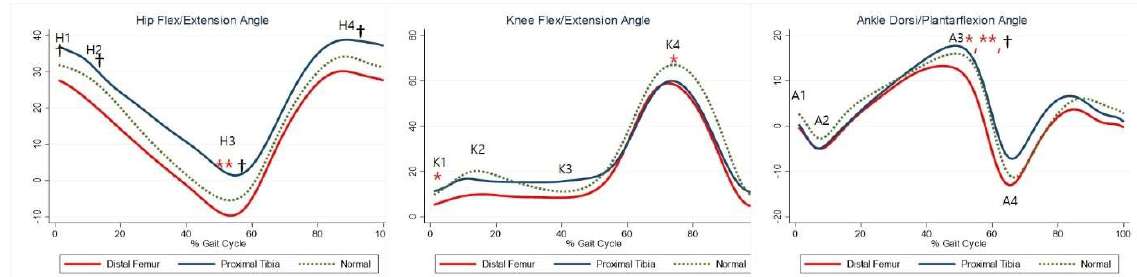
Figure 2. Gait kinematics for each group. The red lines represent mean values for the distal femur group. The blue lines represent mean values for the proximal tibia group. The dashed lines represent the healthy subjects. * Statistically significant for the comparison between distal femur group and healthy subjects. ** Statistically significant for the comparison between proximal tibia group and healthy subjects. † Statistically significant for the comparison between distal femur group and proximal tibia group.